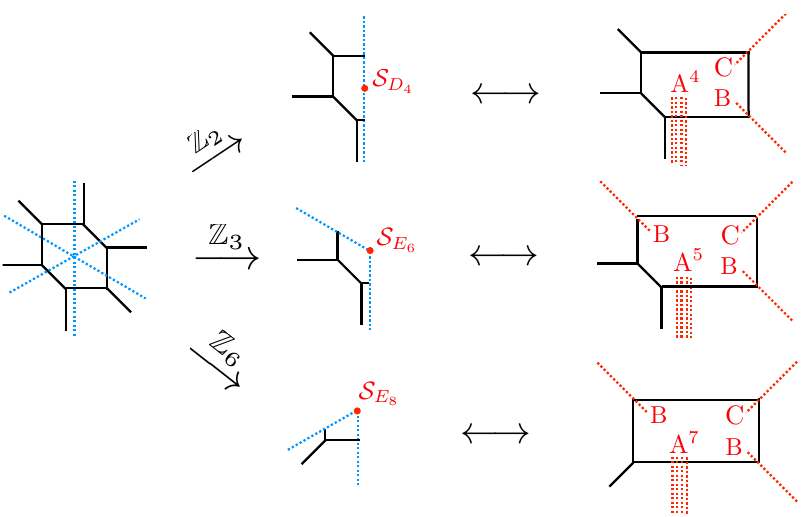
Figure 12 . Brane web for the SU(2) + 2 F theory and its Z 2 , 3 , 6 quotients. For Z 6 , the first diagram is reflected along the vertical line and then its lower left corner slice becomes the second bottom